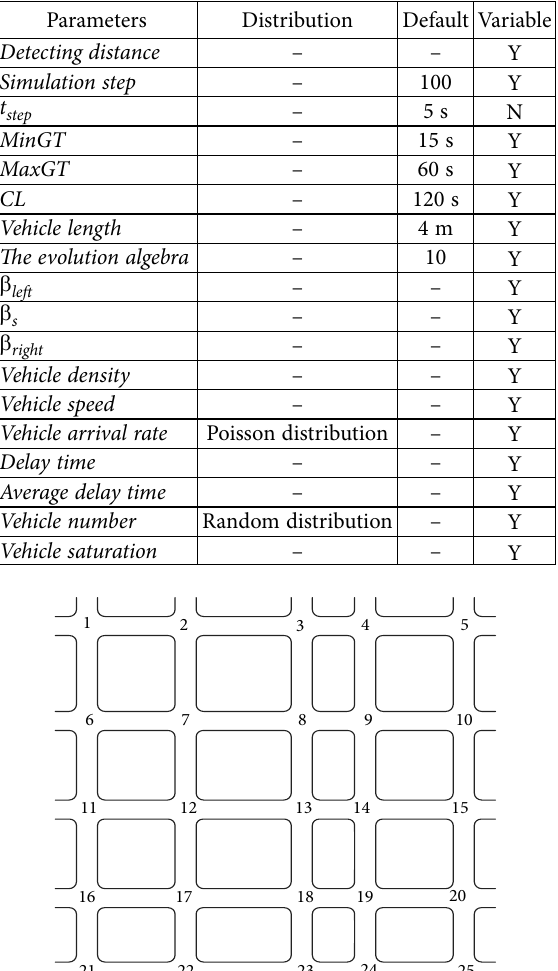
Table 4. The parameters setting in the experiment